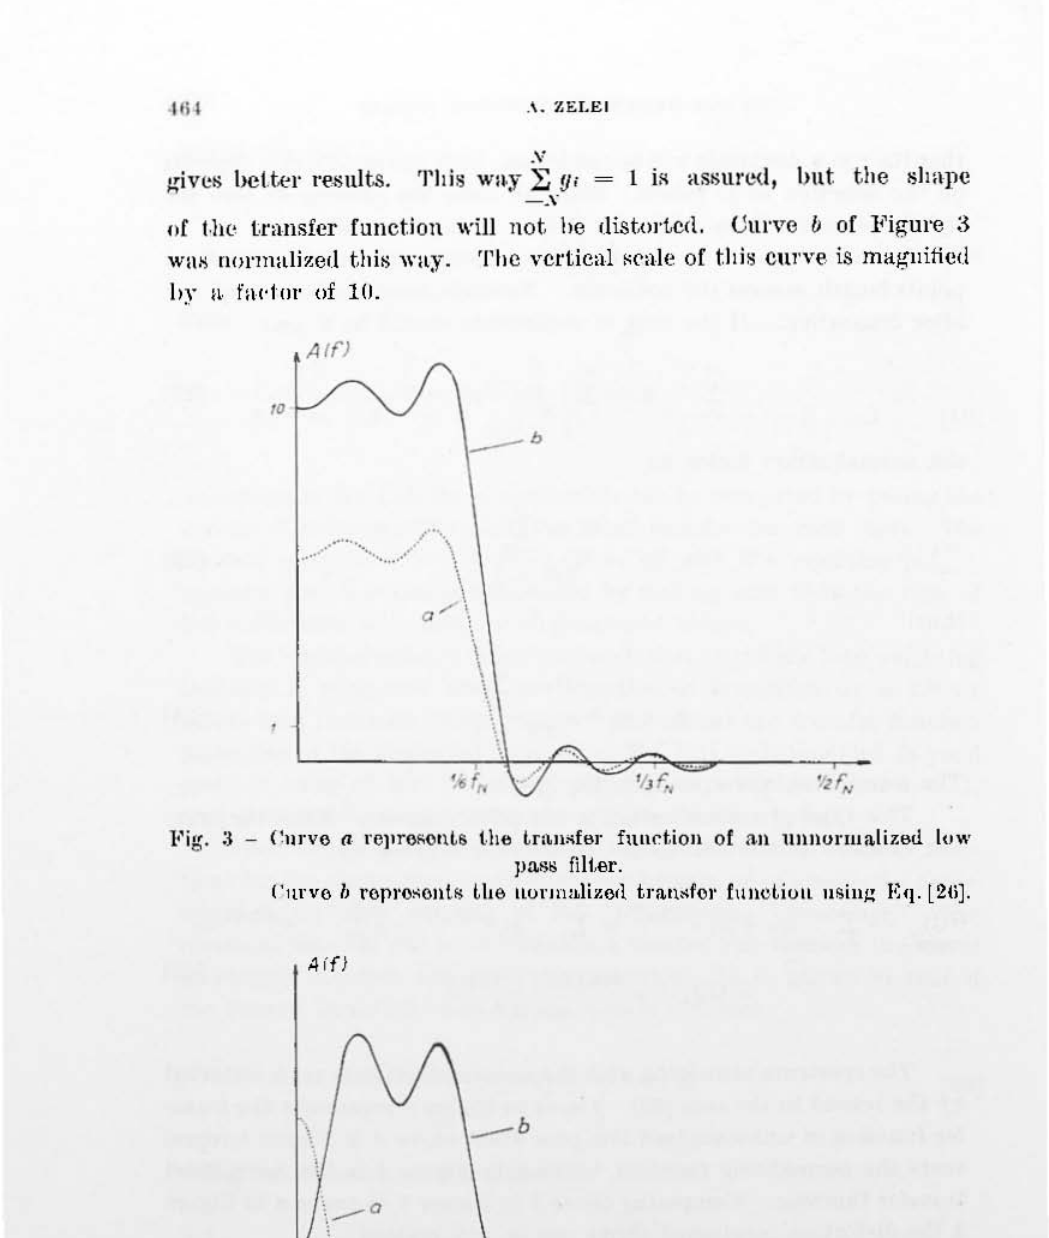
Fig. ;) - ('urV6 (I rO)lr6l'6l\ls th~ tmu>ifer fll11diOIl of lUI llllllvruHdizoo low pM!;